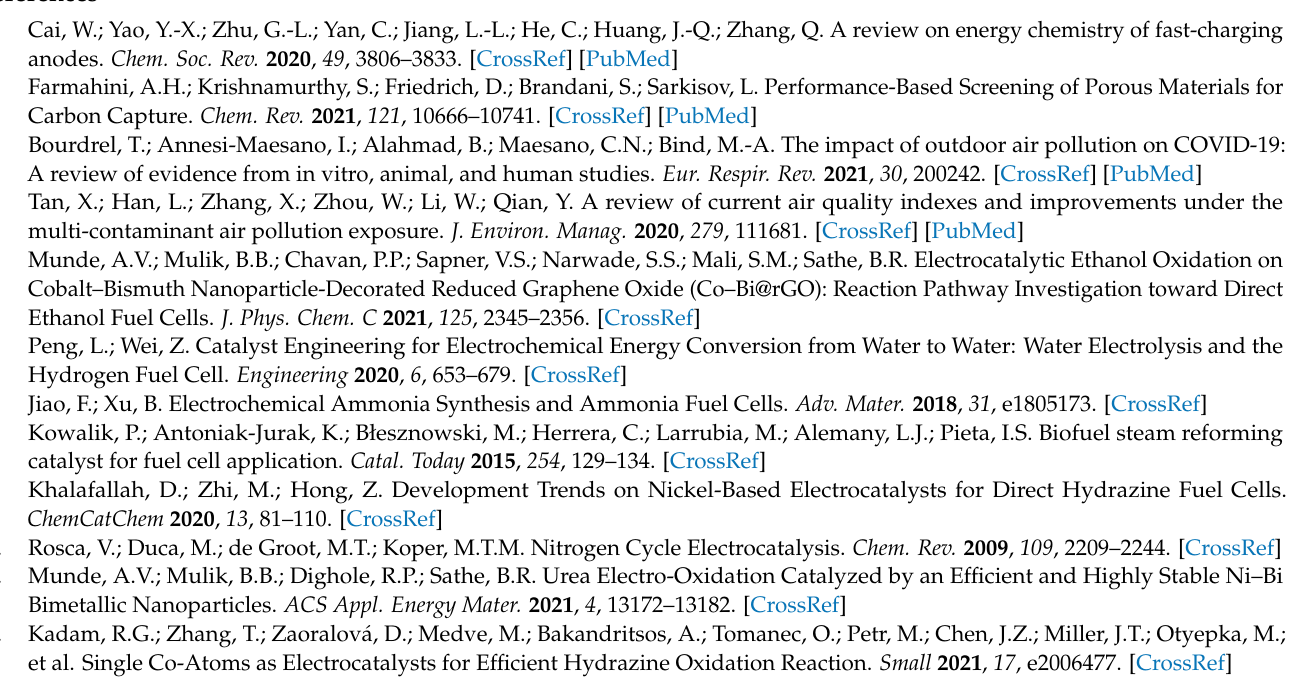
Figure S1: Wide-angle XRD pattern of SRu-mC 3 N 4 ; (a) mC 3 N 4 ; and (b) SRu-mC 3 N 4 ; Figure S2: High-resolution XPS spectra of SRu-mC 3 N 4 : (a) Full scan; (b) N1s spectra of SRu-mC 3 N 4 ; (c) Ru 3d High-resolution XPS spectra of SRu-C 3 N 4 with carbon; Figure S3: Superimposed linear sweep voltammetry (LSV) for the (I) SRu-mC 3 N 4 in 0.5 M KOH (II) SRu-mC 3 N 4 in 6 µ M N2H4 + 0.5 M KOH at a scan rate of 50 mV/s; Figure S4: (A) (i) equivalent circuit and (ii) their values for SRu-mC 3 N 4 , (B) Bode plot calculated by using EIS data of different electrocatalysts in 6 µ M N 2 H 4 + 0.5 M KOH; Figure S5: Chronoamperometric studies of SRu-mC 3 N 4 in 6 µ M N2H4 + 0.5 M KOH at an applied potential of 1.3 V vs. RHE (based on obtained current density of 20 mA/cm 2 ); Figure S6: (A–D) HR- TEM images, and (E) Raman spectra of SRu-mC 3 N 4 catalyst after electrocatalytic hydrazine oxidation reaction study; Table S1: Electrochemical performance of previously reported HzOR systems from the literature. References [40–48] are cited in Supplementary